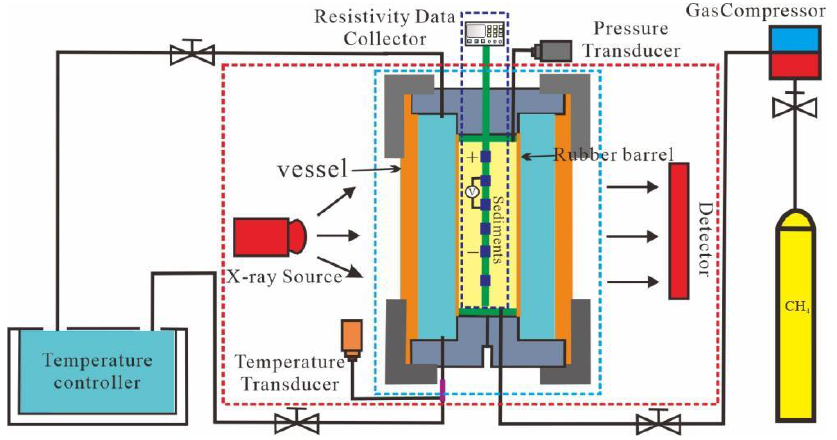
Figure 1. Schematic of experimental device.